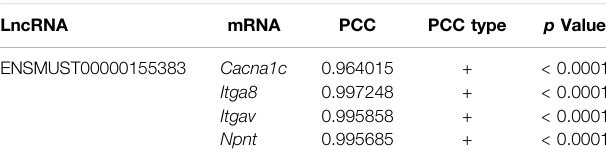
TABLE 1 | The co-expression analysis between lncRNA ENSMUST0000055383 and four mRNAs.